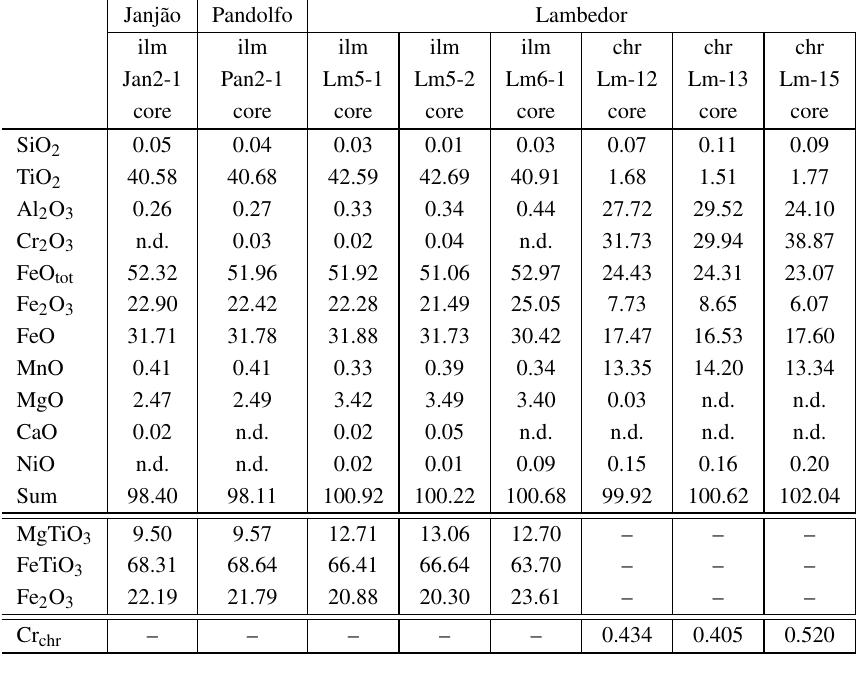
Representative electron microprobe analyses of chromites and ilmenites. Fe 2 O 3 contents calculated using the equation of Finger (1972); Cr chr = Cr/(Al+Cr); n.d., not detected. Janjão